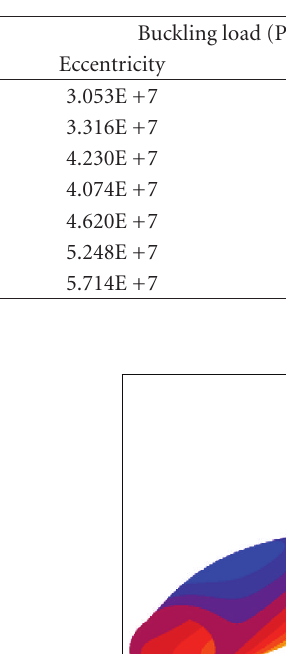
Figure 4: Diagrams stress versus strain. Table 2: Buckling loads for perfect and imperfect shells.